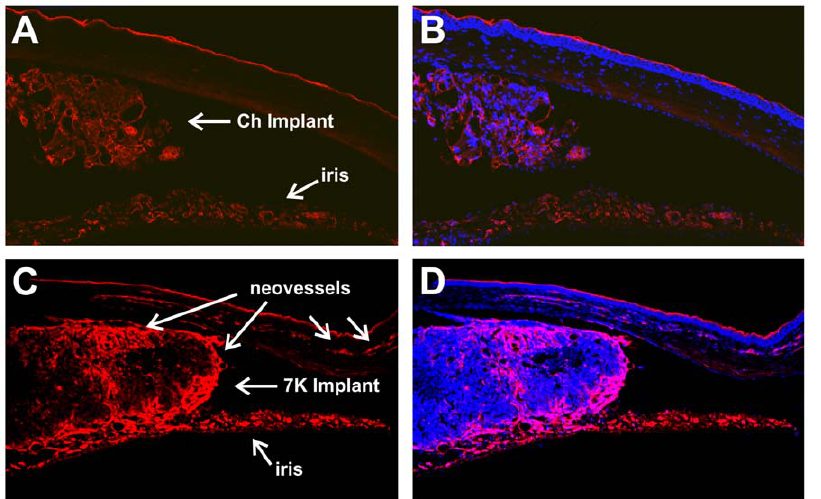
Figure 6. Histological comparison of Ch and 7KCh implants using isolectin IB 4 . Rat eyes were implanted with 20% Ch and 7KCh wafers and cryosections prepared 14 days post implantation. A. Ch implant labeled with isolectin IB 4 . B. Ch implant dual labeled with DAPI. C. 7KCh implant labeled with isolectin IB 4 . D. 7KCh implant dual labeled with DAPI.